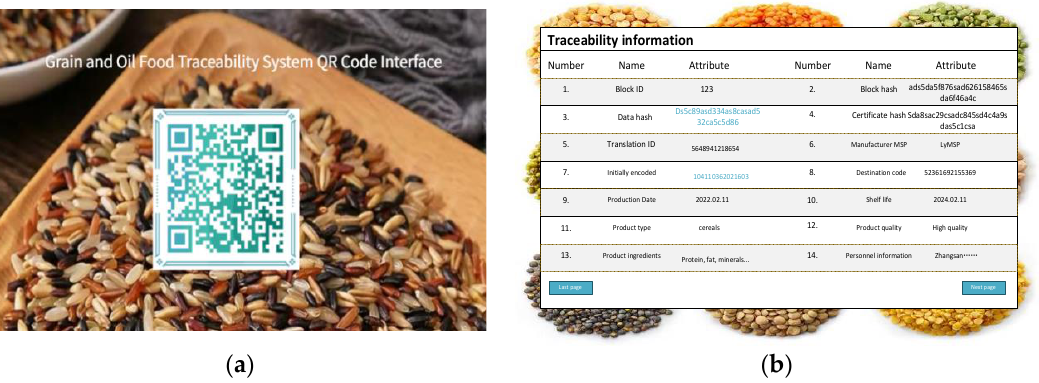
Figure 10. Traceability information query diagram. ( a ) Displays system QR code scanning interface; ( b ) Displays the interface for obtaining detailed data information after scanning is completed. There were 1568 batches of rice involved in this time period, and the accuracy rate of traceability information was 100%. This result shows that the system can effectively achieve credible traceability. In addition, in this study, the identification code information